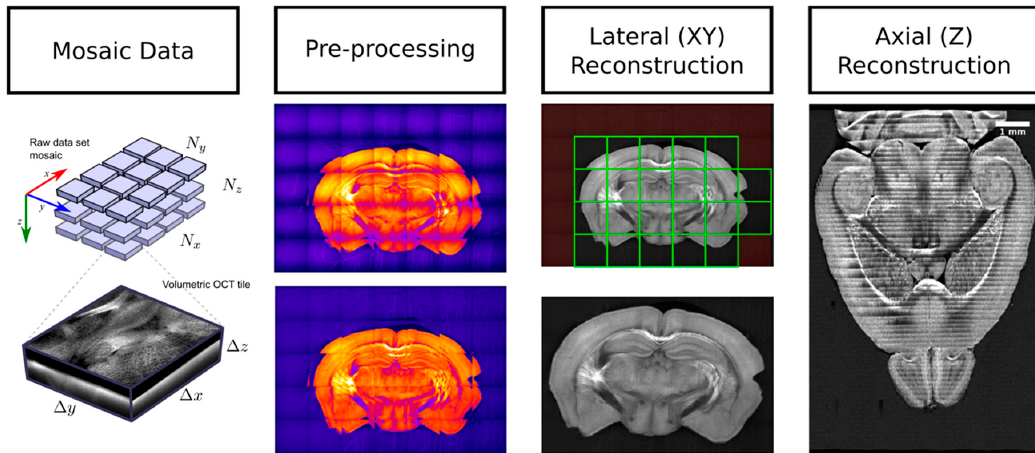
Figure 3. A representation of the principal data reconstruction steps used for SBH, which consists in preprocessing (here, vignetting correction is illustrated), lateral (XY) reconstruction of each tissue slices, and the stitching of each slices along the z-axis to obtain a complete 3-D representation of the whole mouse